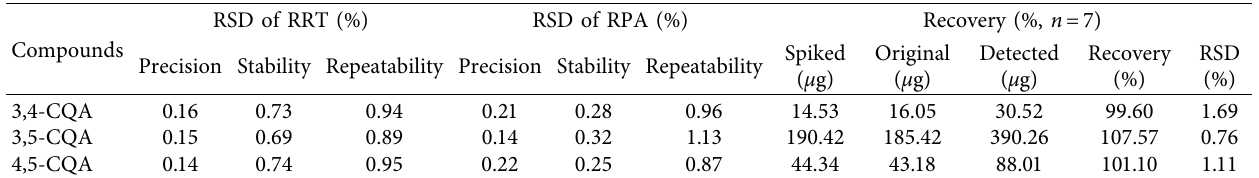
Table 3: Analytical results of precision, stability, and reproducibility test of three marker